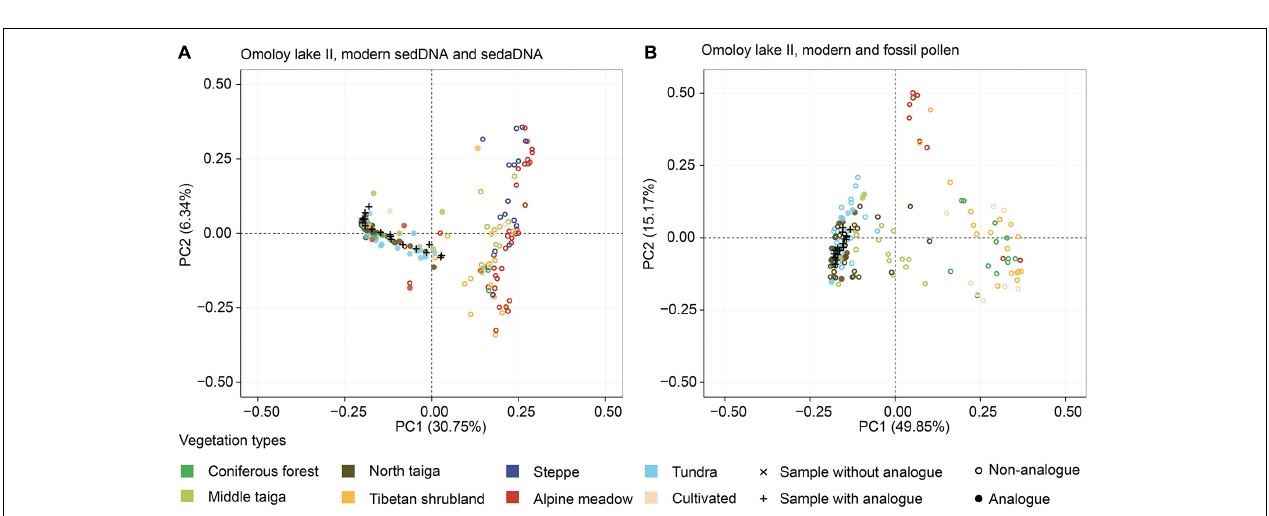
FIGURE 6 | Plots of the principal component analysis (PCA) showing the ordination of fossil assemblages (black or grey) and modern assemblages (coloured according to vegetation type) from Lake Naleng. PCA site scores explain 36.89 and 65.55% of the total variance of the log-chord transformed modern sedDNA training-set (A) and modern pollen data (B) , respectively. PCA of modern sedDNA and sedaDNA indicate that the vegetation composition of the pre-14 ka glacial assemblages is mostly herbaceous, whereas post-14 ka assemblages (“+”) are similar to forests. PCA of modern and fossil pollen show that the vegetation composition of fossil samples is quite different from modern ones although they are clustered around meadow sites.